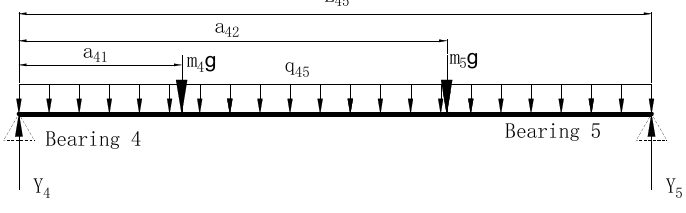
Figure 4. Applied forces of the outer rotor.